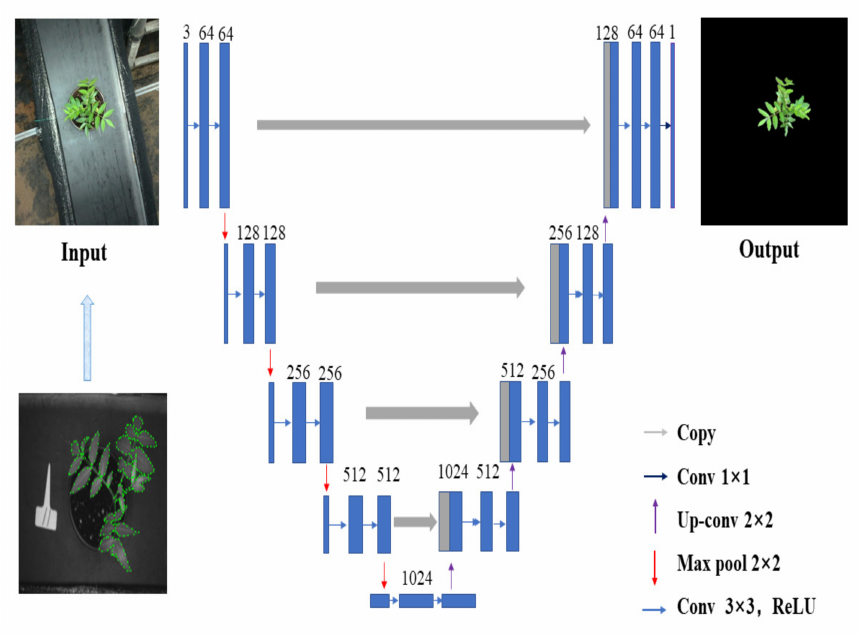
Figure 2. The architecture of U-Net for T. sinensis leaf segmentation.